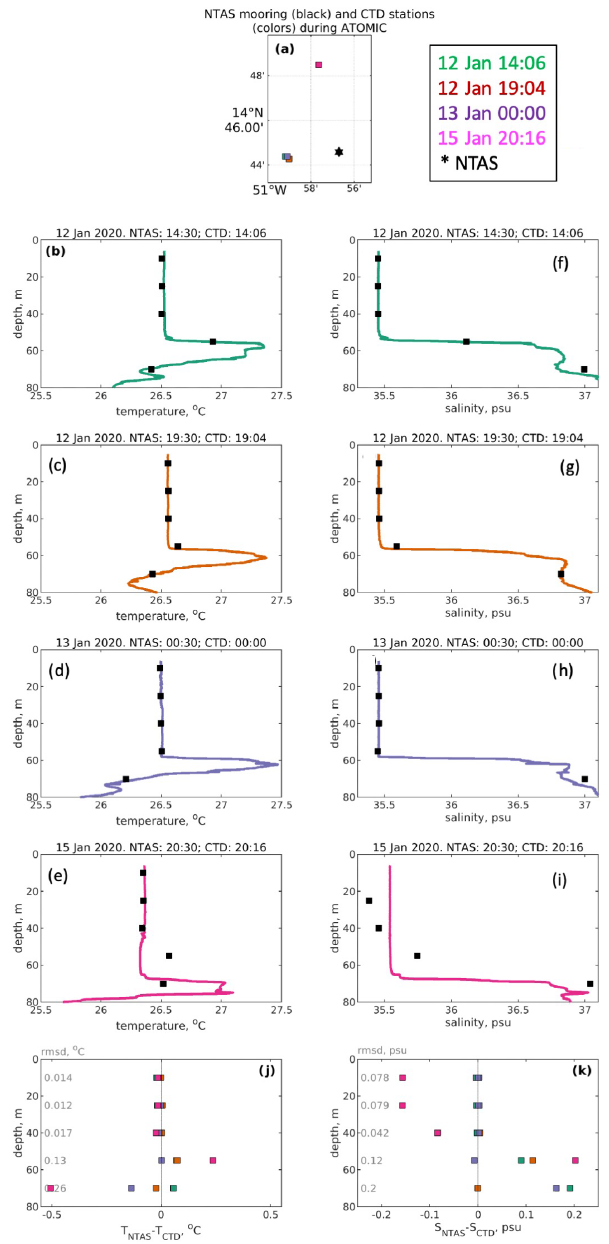
Figure 5. Comparison of upper ocean measured parameters from the NTAS-18 mooring and the RV Ronald H. Brown on 12, 13, and 15 January with (a) location of NTAS-18 mooring anchor. The NTAS buoys were about 2nmi downwind (SW) of the anchor, so the CTD and mooring measurements were within 0.5 to 3nmi of each other. Also shown are (b–e) temperature, (f–i) salinity, and (j– k) absolute differences and root mean square differences (RMSDs) for temperature and salinity, respectively. Number of samples =